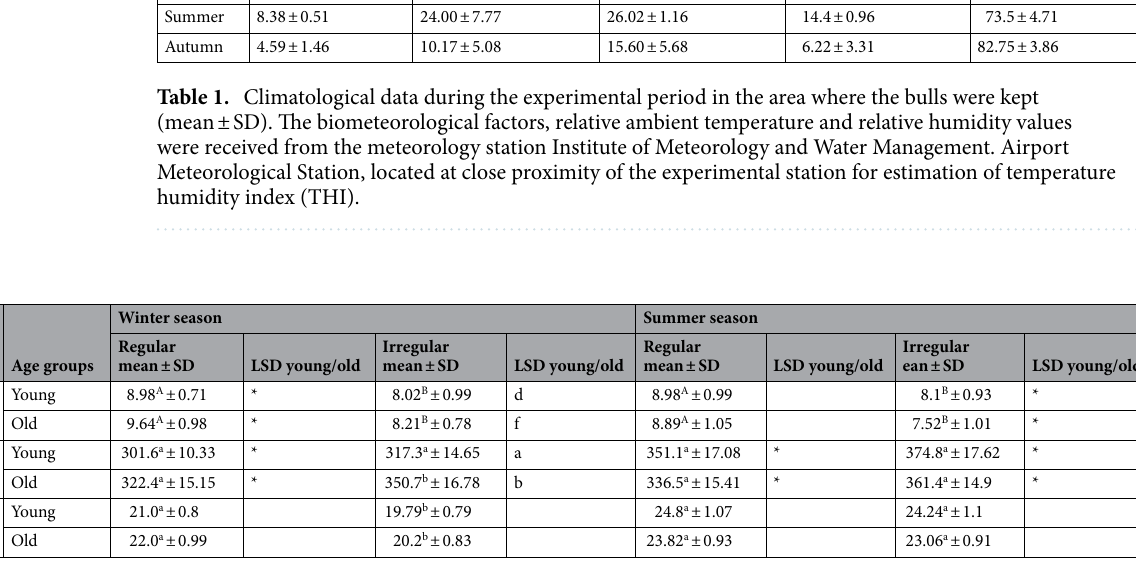
Table 2. Testosterone, estriadol and prostaglandin concentrations depending on the season and age of the male subjects (mean ± SD). Explanation: different letters in the same lines differ significantly; a, b ( P < 0.05), A, B ( P < 0.01); * P < 0.05; ** P < 0.01; LSD least significant